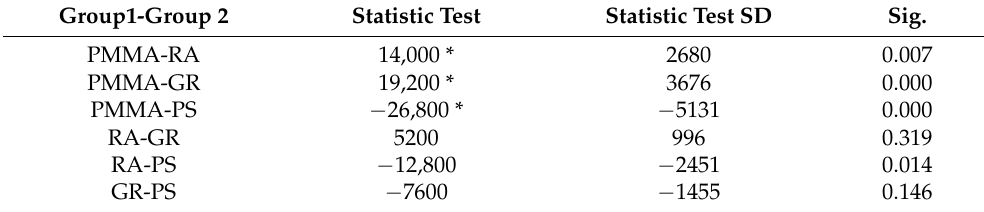
Table 3. Paired comparison test